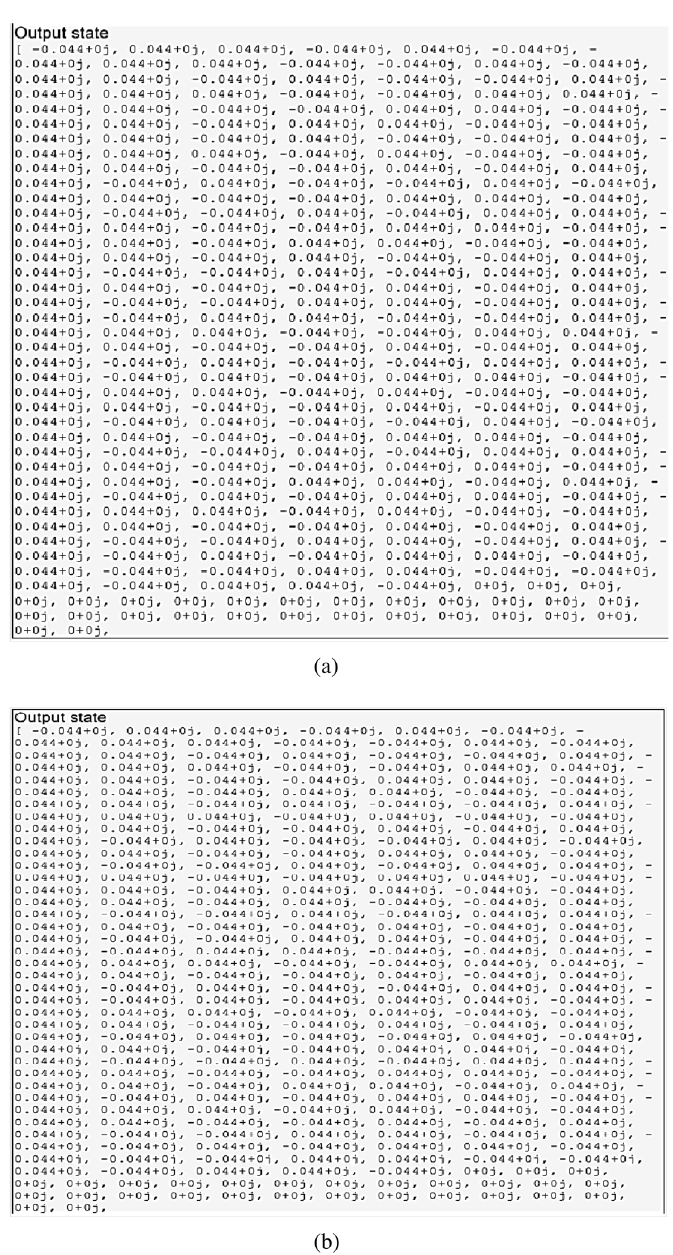
Figure 13. The simulation result of the output of the quantum neural network circuit before and after optimization in ( a ) and ( b ) respectively. The results are